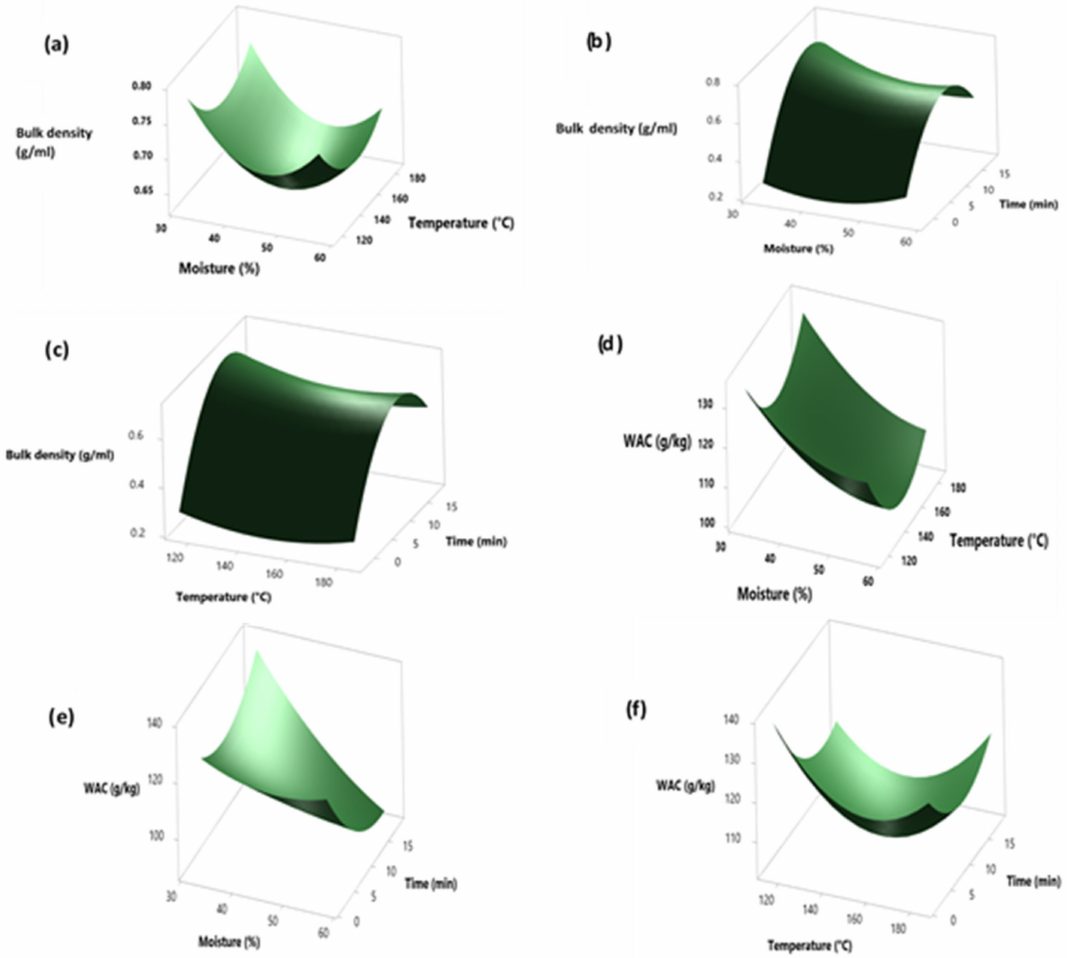
Figure 1. Surface plots of bulk density and water absorption capacity (WAC). Plots: ( a ): effect of moisture–temperature, ( b ): effect of moisture–time, ( c ): effect of temperature–time on bulk density; ( d ): effect of moisture–temperature, ( e ): effect of moisture–time, ( f ): effect of temperature–time on